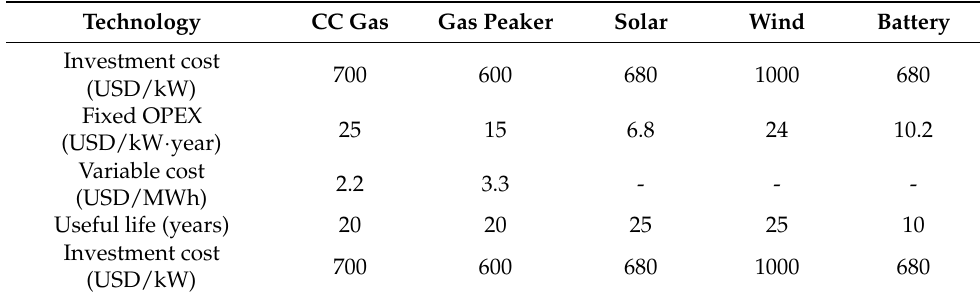
Table 1. Assumptions for expansion technologies in